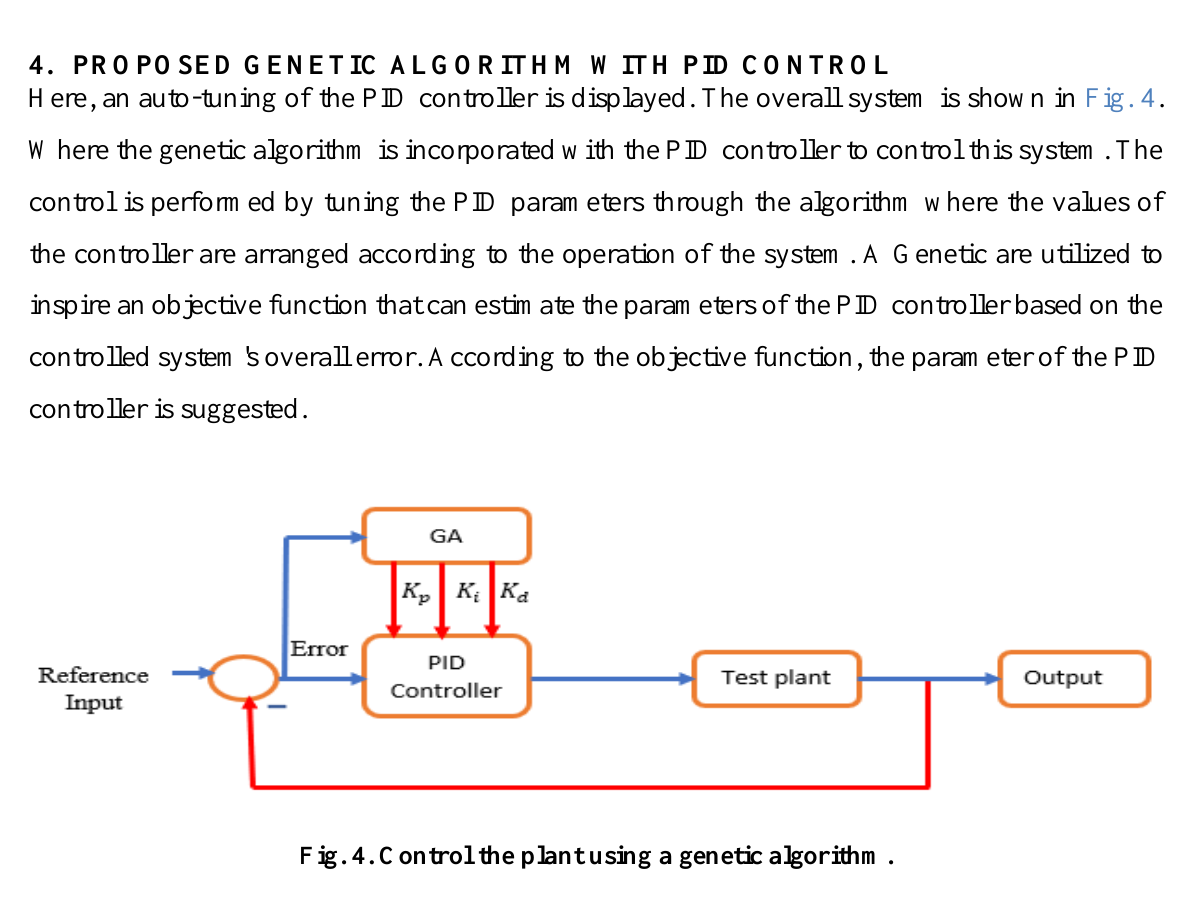
Fig. 3. Flowchart of a genetic algorithm.